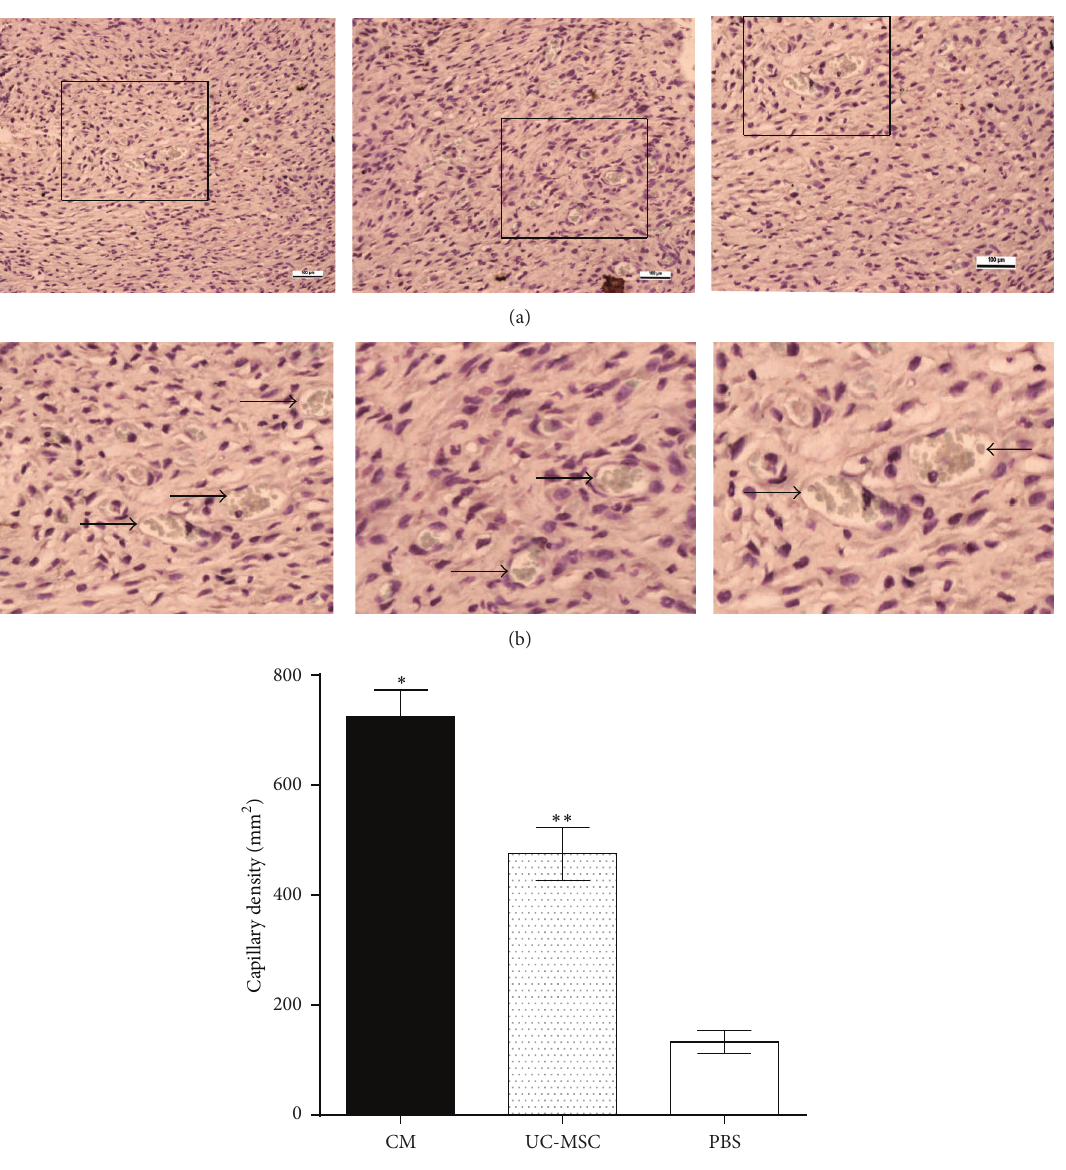
Figure 3: Capillary density in 14-day-old wounds was determined after immunohistochemistry. Scale bar is 100 𝜇 m. (a) Images of CM-, UC- MSC-, and PBS-injected tissues from left to right, respectively (20x). (b) Magnified images of CM-, UC-MSC-, and PBS-injected tissues from left to right, respectively. (c) Capillary density as the number of vWF-positive vessels per mm 2 ( 𝑛 = 6 ; ∗ 𝑃 < 0.05 , CM versus UC-MSC or PBS); ( 𝑛 = 6 ; ∗∗ 𝑃 < 0.05 , UC-MSC versus